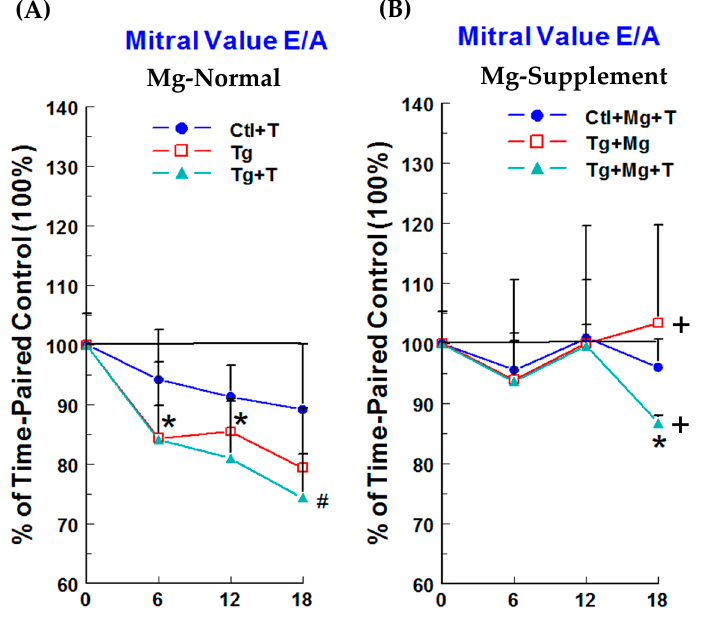
Figure 5. Temporal effects of HIV-1 expression ± cART (T) on LV diastolic function (mitral valve E/A ratio) of Mg-normal ( A ) and Mg-supplemented ( B ) rats during 18 weeks. E/A was monitored by echocardiography. Values are means ± SE = 5 rats/group. * p < 0.05, # p < 0.02 vs. Ctl (100%); + p < 0.05 vs. Mg-normal counterparts.